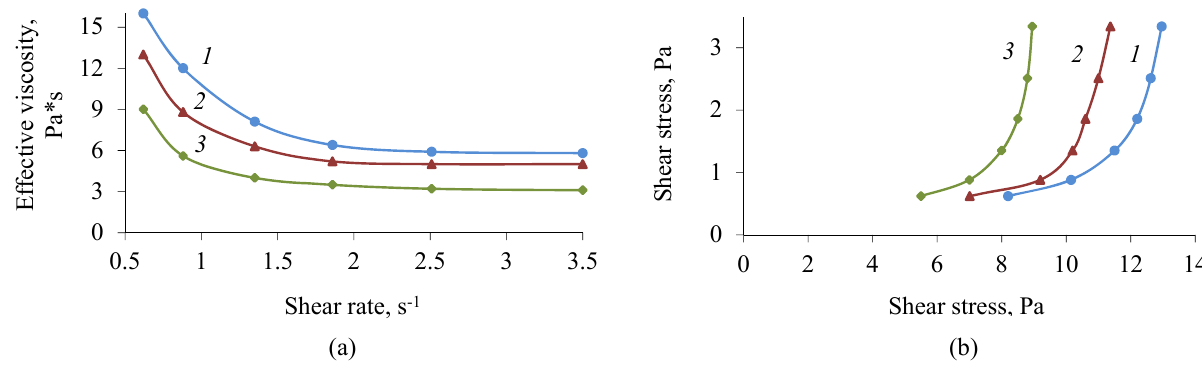
Fig. 5. Dependence of the effective viscosity of jelly mass based on agar on the shear rate (a) and flow curves (b) at t = 50°C of the jelly mass based on agar and: ( 1 ) molasses + sugar + apple puree (control); ( 2 ) stevioside + apple puree; ( 3 ) stevioside + juice from sea buckthorn berries.